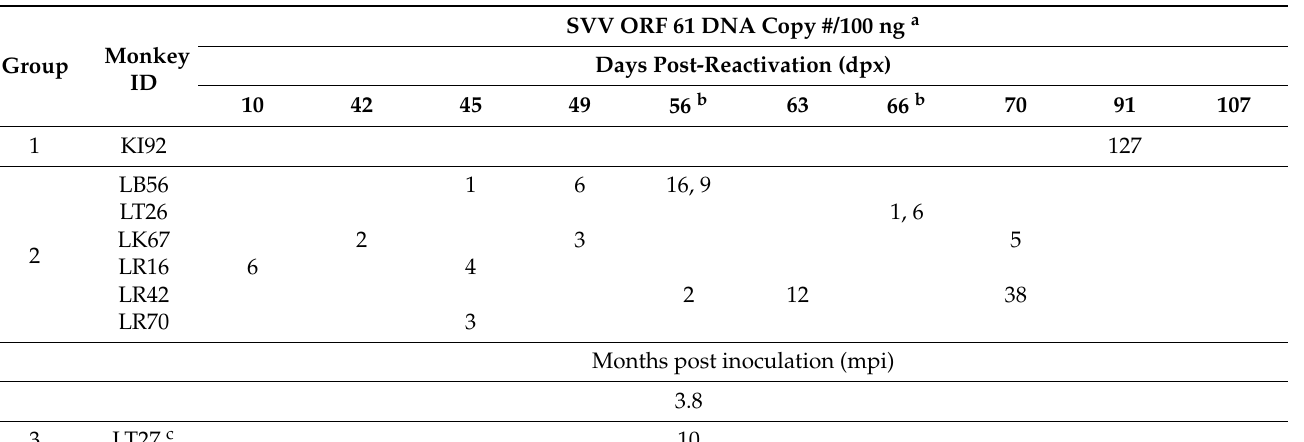
Table 6. Detection of SVV DNA in skin scrapings during zoster.